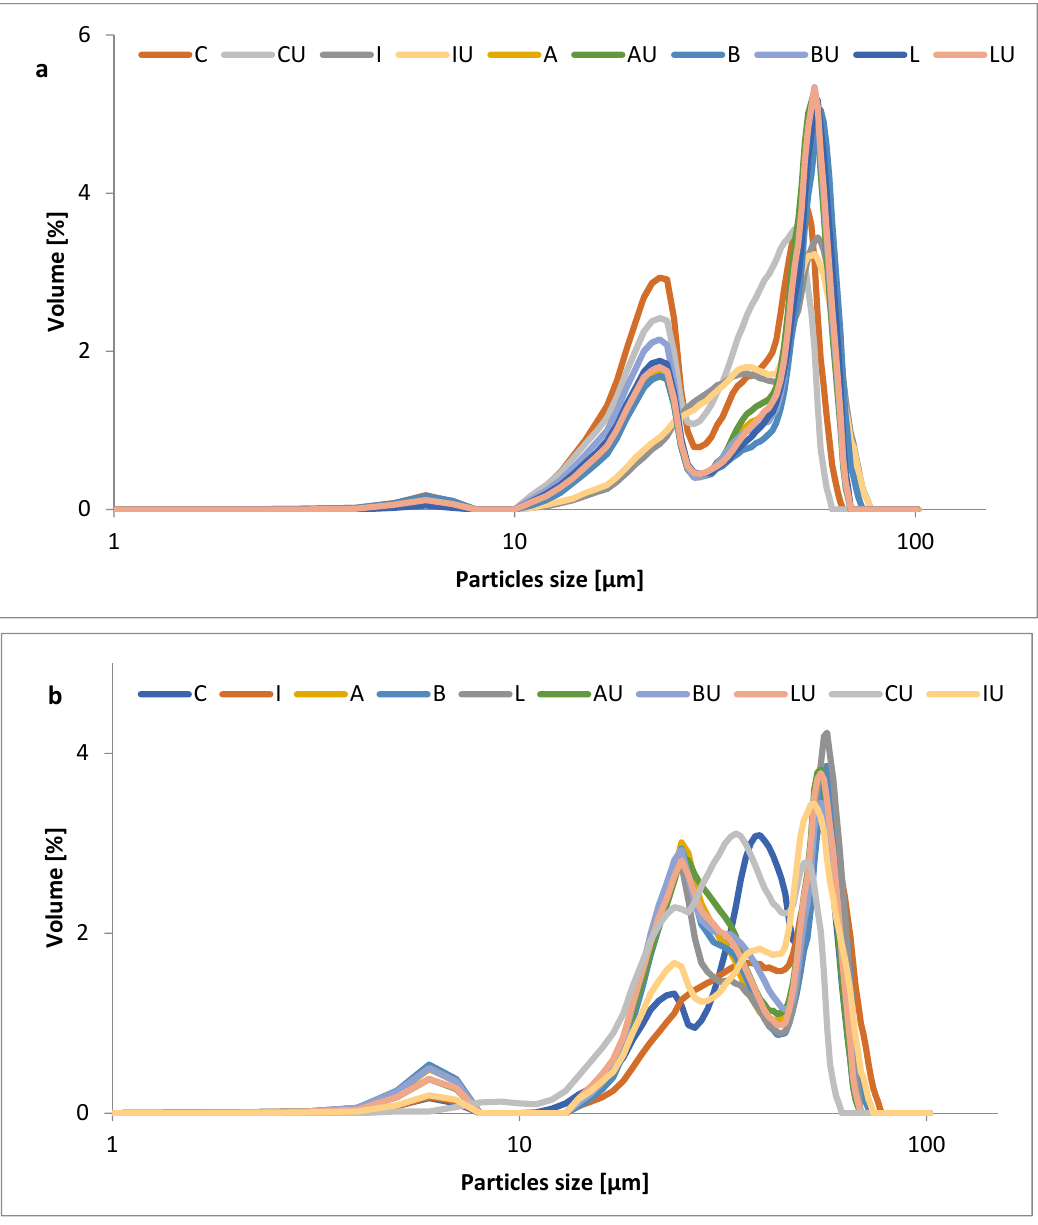
Figure 3. The distribution of particle size: ( a ) before the maturation of ice cream mixes; ( b ) after the maturation of ice cream mixes (for 24 h; at 4 °C).